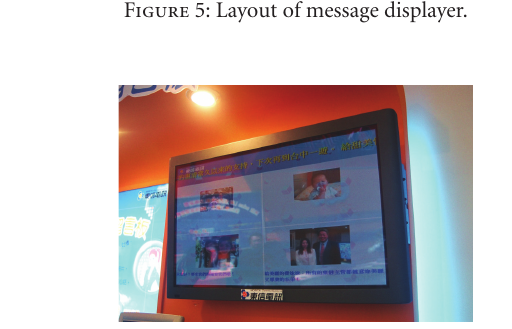
Figure 6: VSMMS on a computer-embedded PDP.